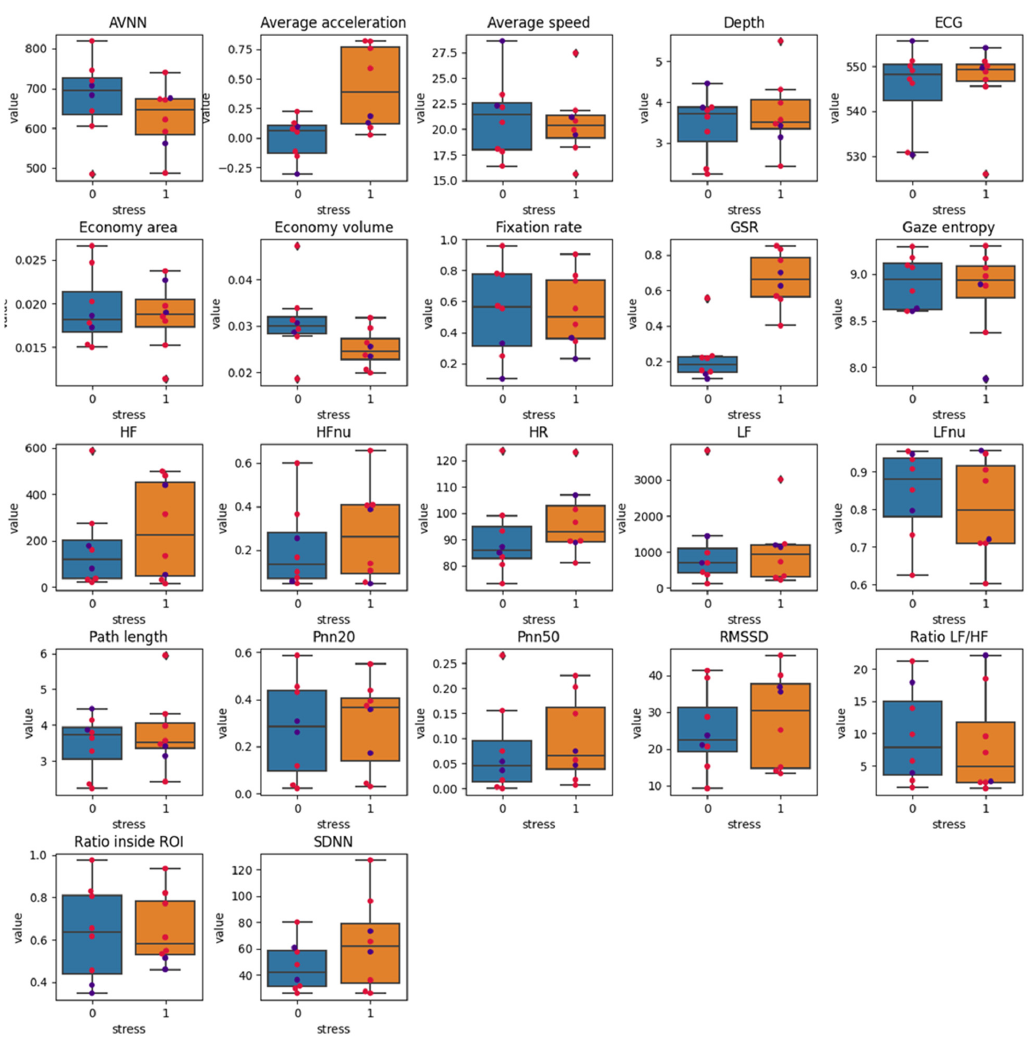
Figure 5. Box plot of phases 1 and 2 of the experiment for each of the metrics. Red and blue dots indicate the value for non-experts and experts, respectively.